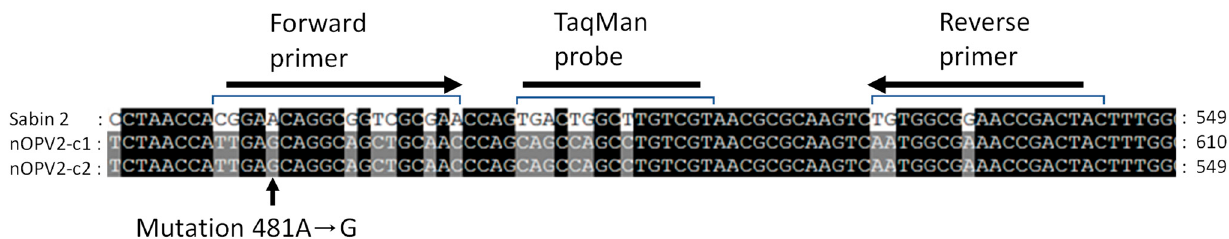
Figure 1. Nucleotide sequences of domain V region of nOPV2 and Sabin 2 viruses. Genomic location of primers and TaqMan probe used for detection and quantitation of Sabin 2 virus in nOPV2 vaccine and mutation 481A → G are indicated.